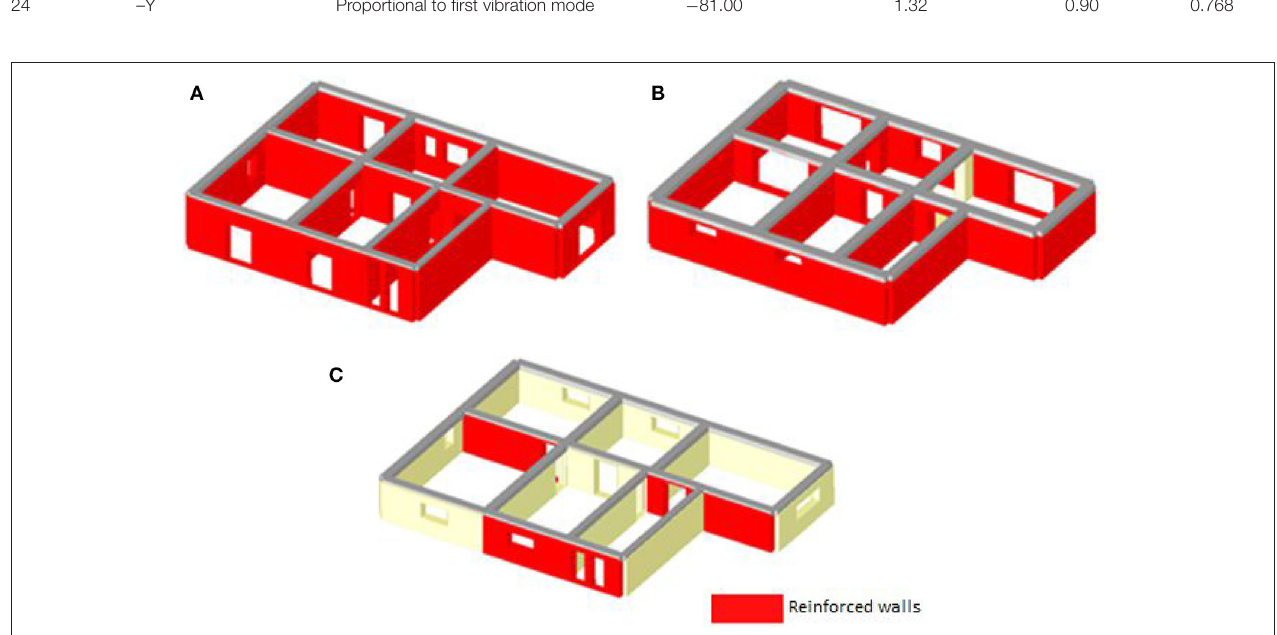
FIGURE 7 | Seismic retrofitting interventions by reinforced plaster on first level (A) , second level (B), and third level (C) masonry walls.